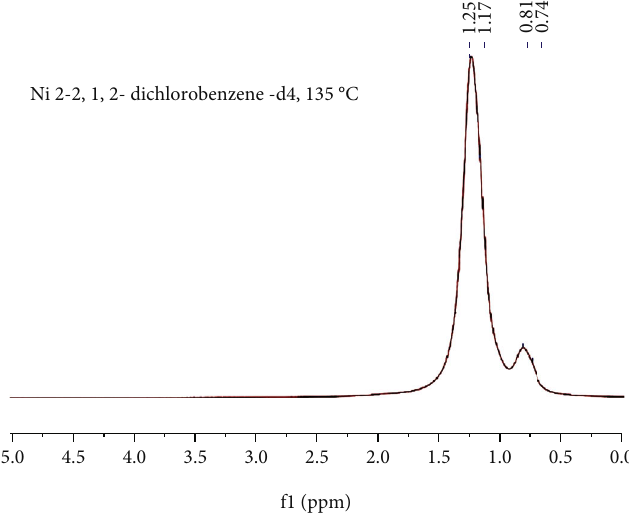
Figure 3: 1 H NMR spectrum for Ni1-2 in 1,2-dichlorobenzene-d4.